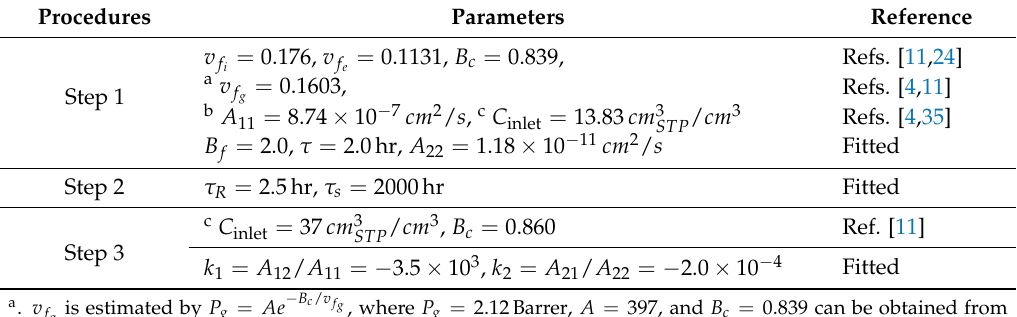
Figure 4. Comparison of the experimental long time CO 2 permeability data (symbols) with the coupled model predictions (lines). Dash lines are the results based on the assumed renewal process of lattice contraction stated in step 2 of this section. The solid line is the result of coupling and accelerated diffusion with parameters Table 2. Model parameters for Matrimid ® thin